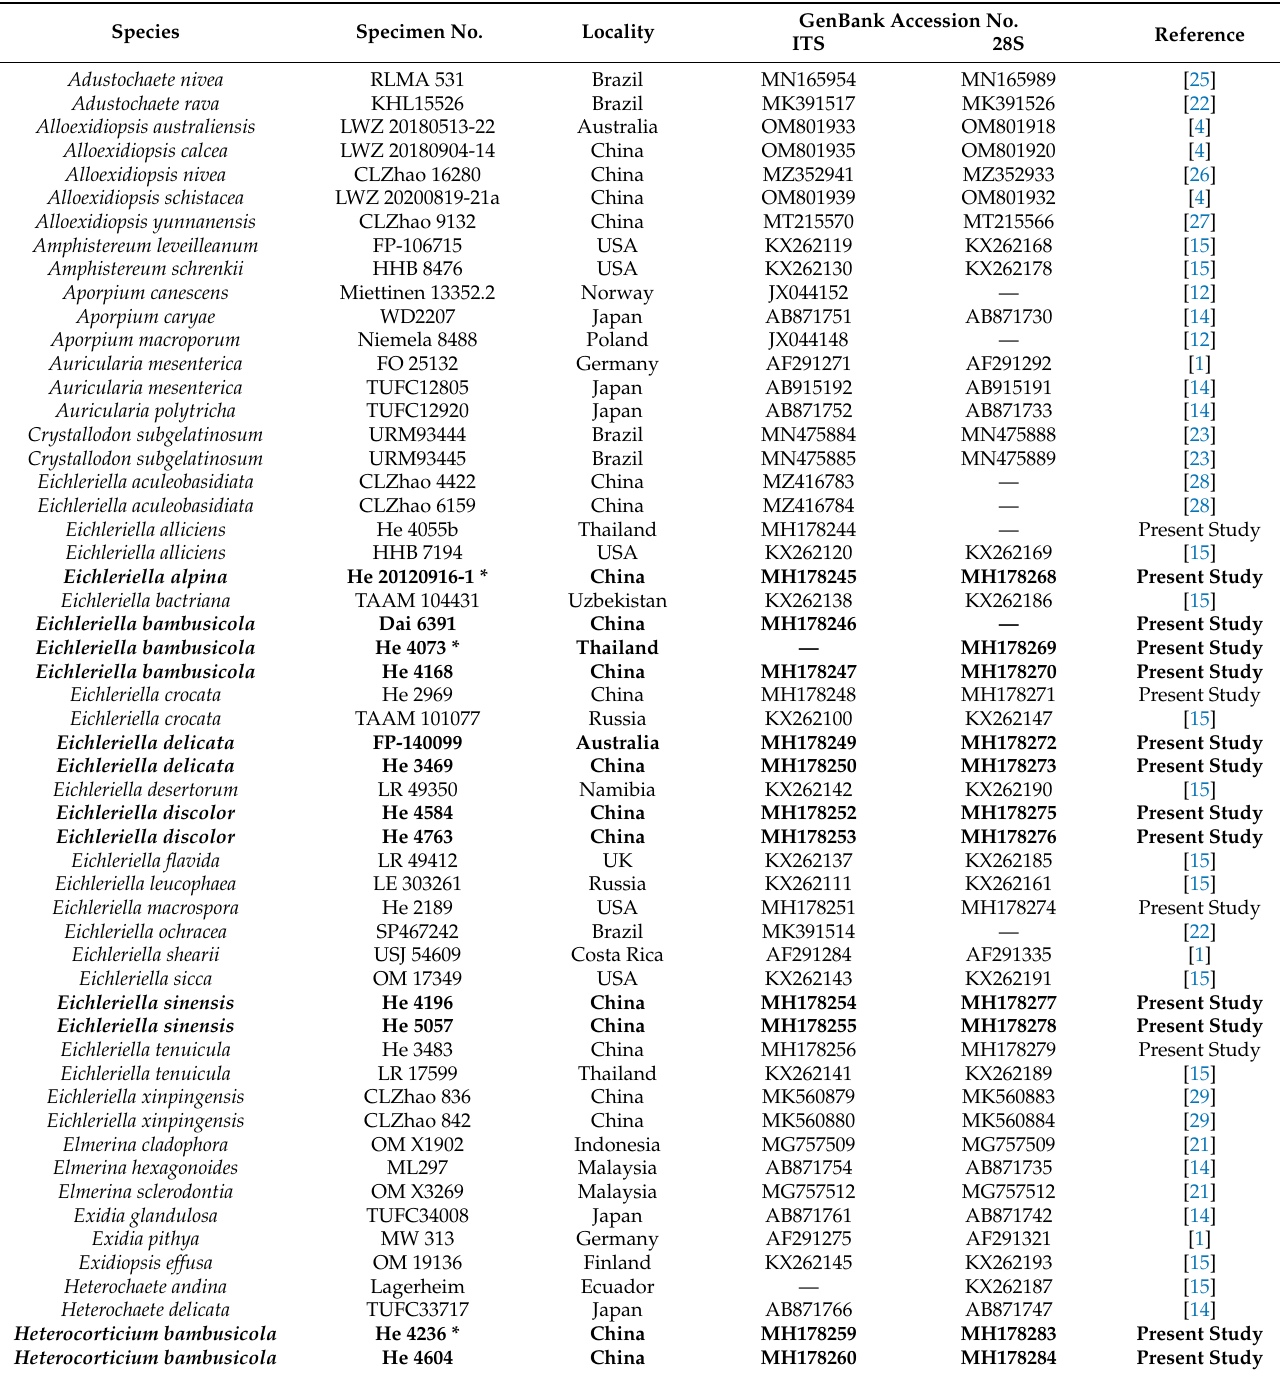
Table 1. Species and sequences used in the phylogenetic analyses. New taxa are set in bold with type specimens indicated with an asterisk